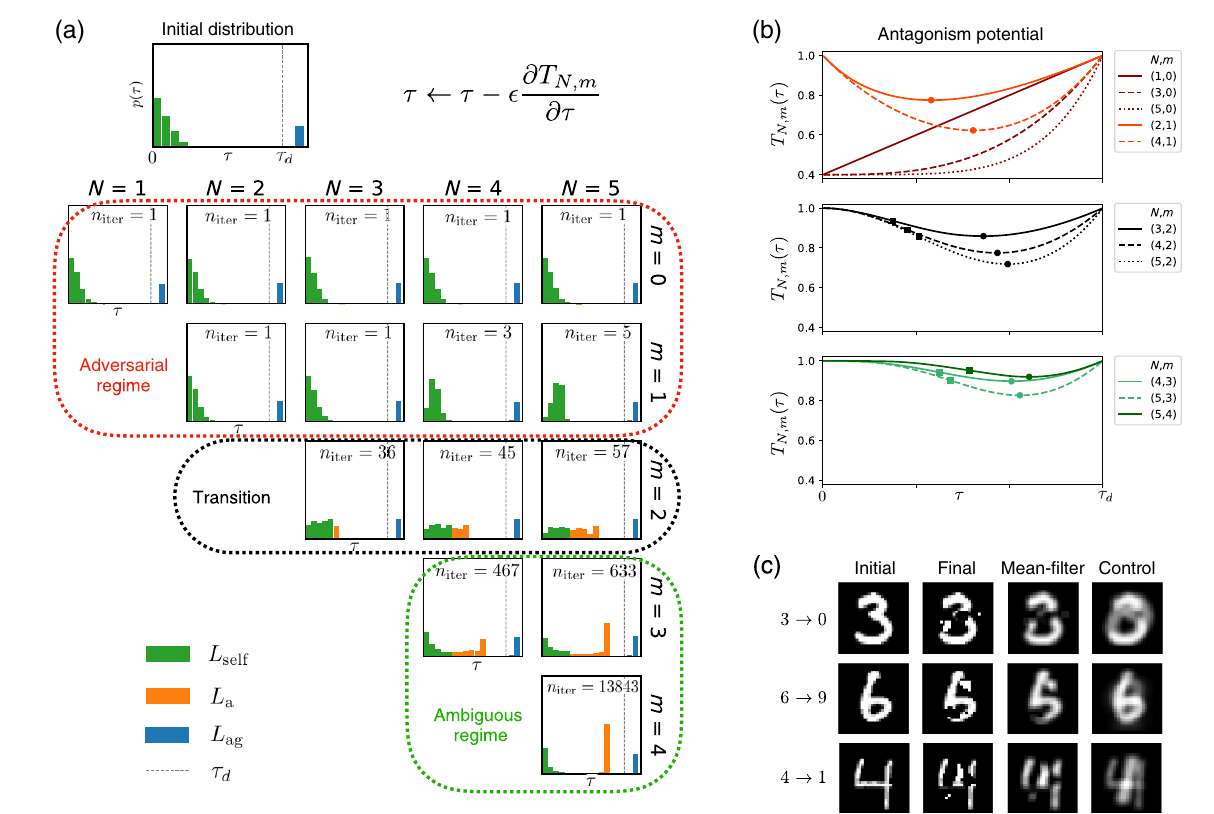
FIG. 4. Characterization of the decision boundary following gradient-descent dynamics. (a) Ligand distribution at the decision boundary by applying iterative gradient descent (top right of the panel) to an initial distribution (top left). For various cases ð N; m Þ , we change the binding time of self-ligands along the steepest gradient until reaching the decision boundary. n iterations needed to reach the decision boundary. We identify the adversarial regime (red), the ambiguous regime (green), and a transition (black) depending on m . (b) T N;m for mixtures of ligands at τ d and ligands at τ , as a function of τ for various ð N; m Þ . Antagonism strength is maximal when T N;m is minimal. Minima and inflexion points are indicated with a circle and square. (c) Few- pixel attack as a way of circumventing proofreading or local contrast defense, while creating ambiguous digits. We add a 3 × 3 mean filter to demonstrate the ambiguity of digits at the decision boundary. The control image is the mean-filtered initial digit combined with the locally contrasted average target digit. Note that also the control is lacking a clear ground